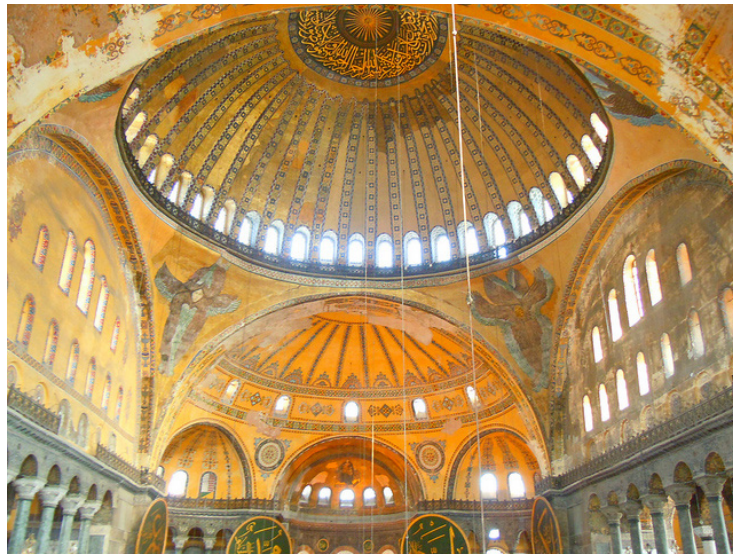
Figure 9. Dome on spandrels at the Hagia Sophia church in Istanbul, Turkey. In the case of the Roman Pantheon (Figure 10), the dome is supported by means of brickwork discharge arches, ribs made of the same material and hydraulic cement mortar the case of Seokguram [15].